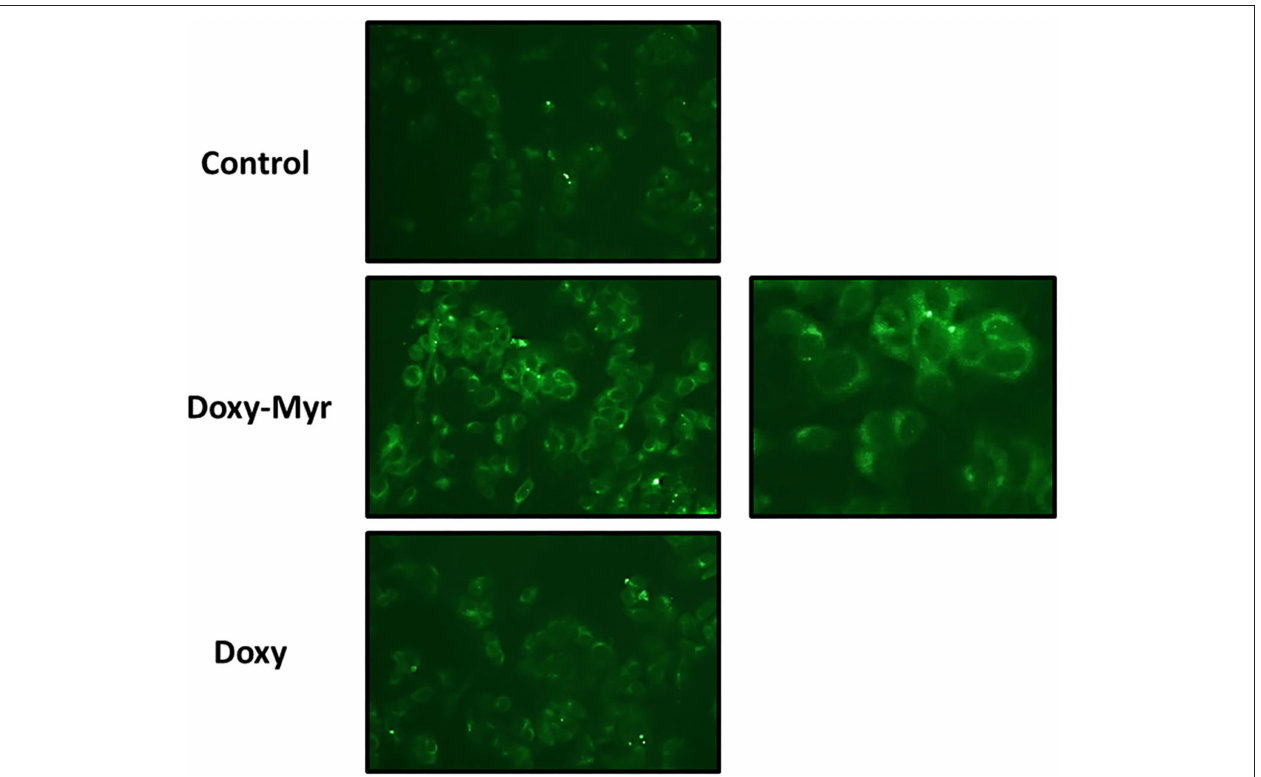
FIGURE 3 | Doxy-Myr is better retained within cells and reveals a peri-nuclear staining pattern. MCF7 cells were cultured for 72h as 2D-monolayers, in the presence of Doxycycline or Doxy-Myr, at a concentration of 10 µ M. Vehicle-alone controls were processed in parallel. Then, MCF7 cells were washed twice with PBS and subjected to live cell imaging to capture the auto-fluorescent signal retained within cells. Note that Doxy-Myr showed the strongest intracellular retention, and was concentrated within peri-nuclear intracellular compartments. No nuclear staining was observed. Quantitation of mean pixel intensity, using Image J software, revealed that relative to Doxycycline, Doxy-Myr showed a near 3-fold increase in intracellular